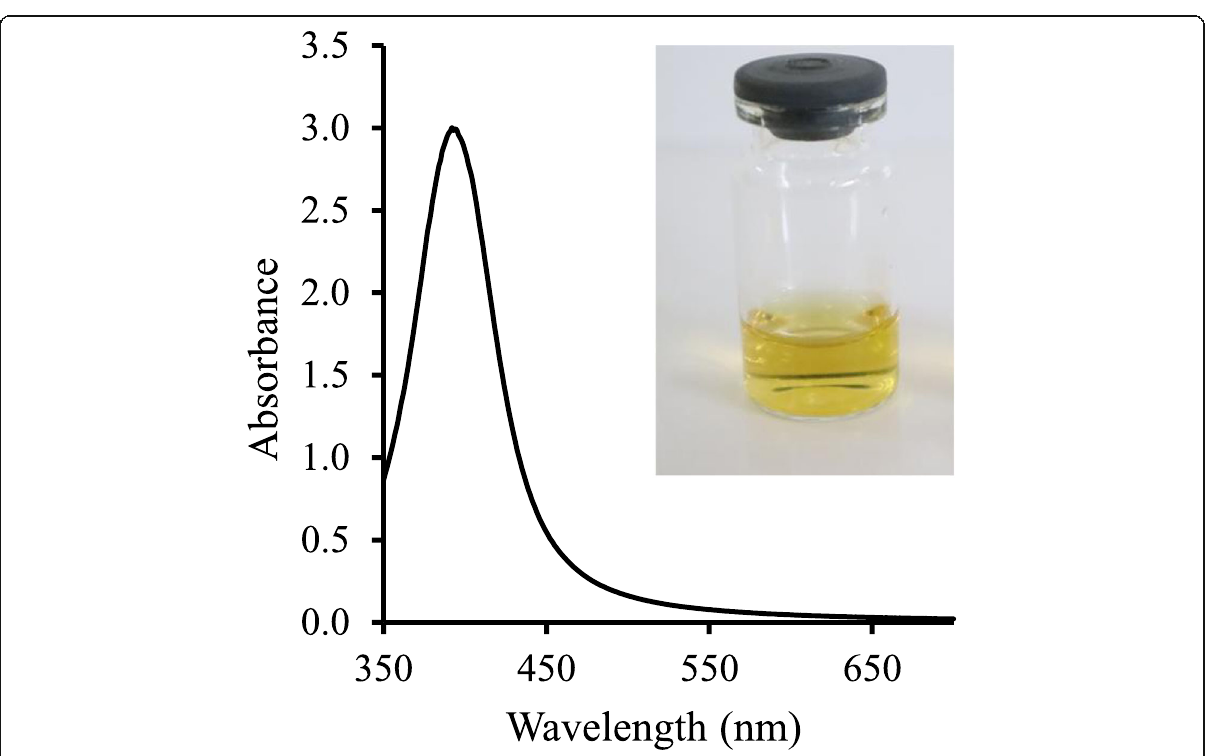
Fig. 1 Bright yellow citrate-stabilized silver nanoparticle solution with absorbance peak at 392